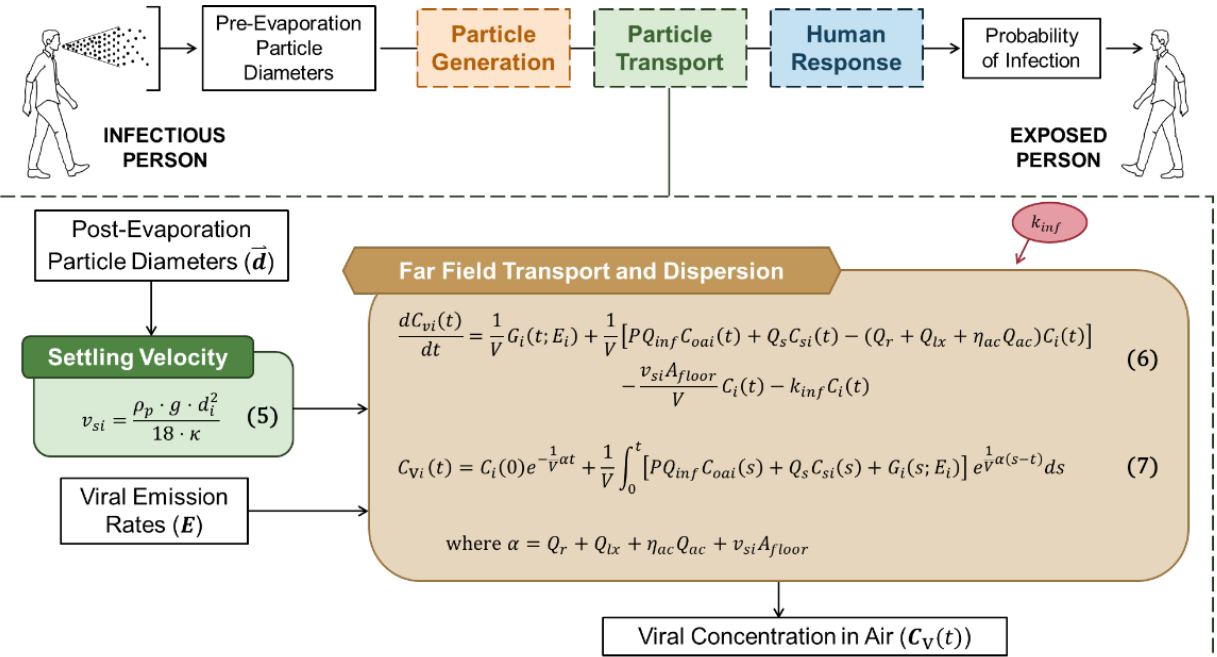
Figure A3. Visualization of the aerosol transport submodel workflow. Equations (6) and (7) are equivalent as the latter is the analytical solution of the former. When executing the workflow, either can be utilized, however, Equation (7) is preferred as the complexity of the numerical integration is reduced, in turn minimizing both the numerical errors introduced and the computational time required. Red circles indicate parameters selected for sensitivity analysis (see Table 2).